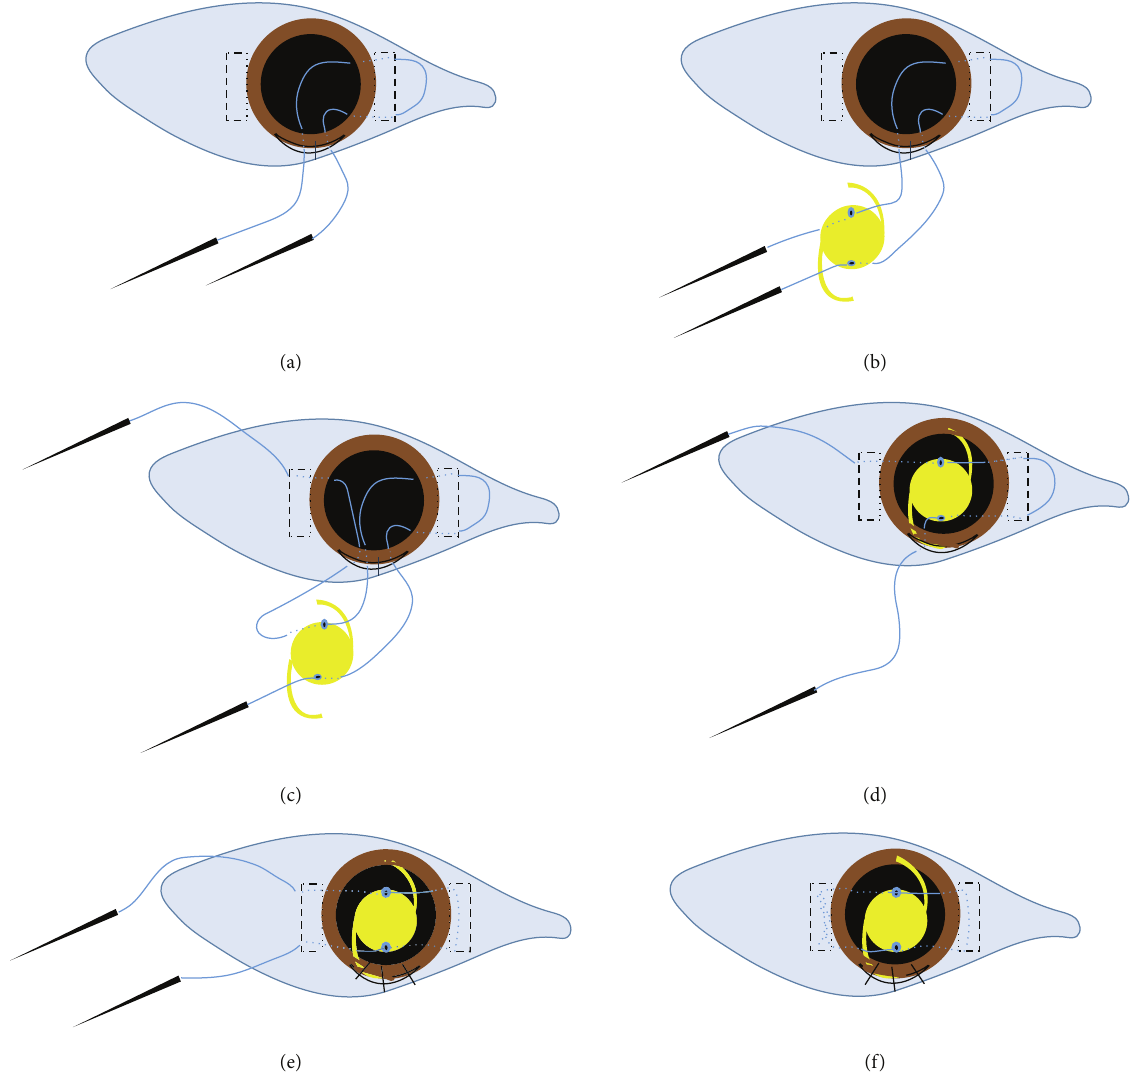
Figure 2: Diagrammatic illustration of the two balanced strings SF-IOL